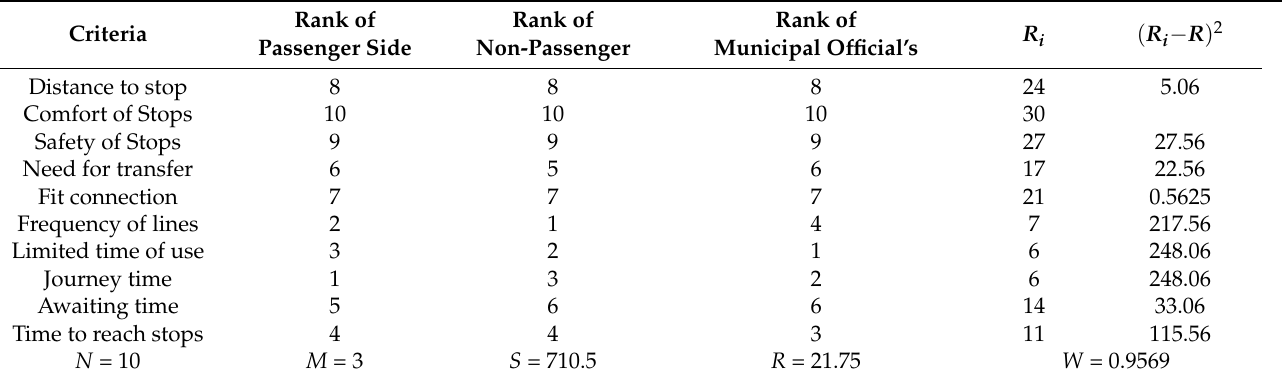
Table 6. Kendall’s coefficient of concordance ( W ) for level